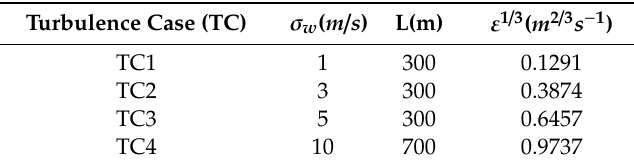
Table 4. Theoretical input turbulence